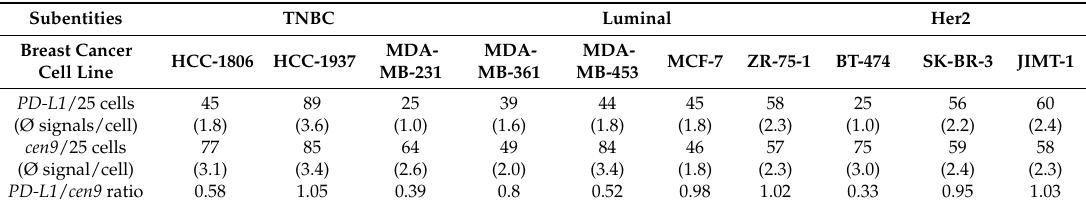
Table 1. Assessment of Programmed Death Ligand 1 ( PD-L1 ) gene copy number in breast cancer (BC) cell lines. PD-L1 and cen9 gene signals derived from 25 cells (and calculated as signal per one cell) as well as PD-L1/cen9 ratio are presented. TNBC: triple-negative breast cancer.